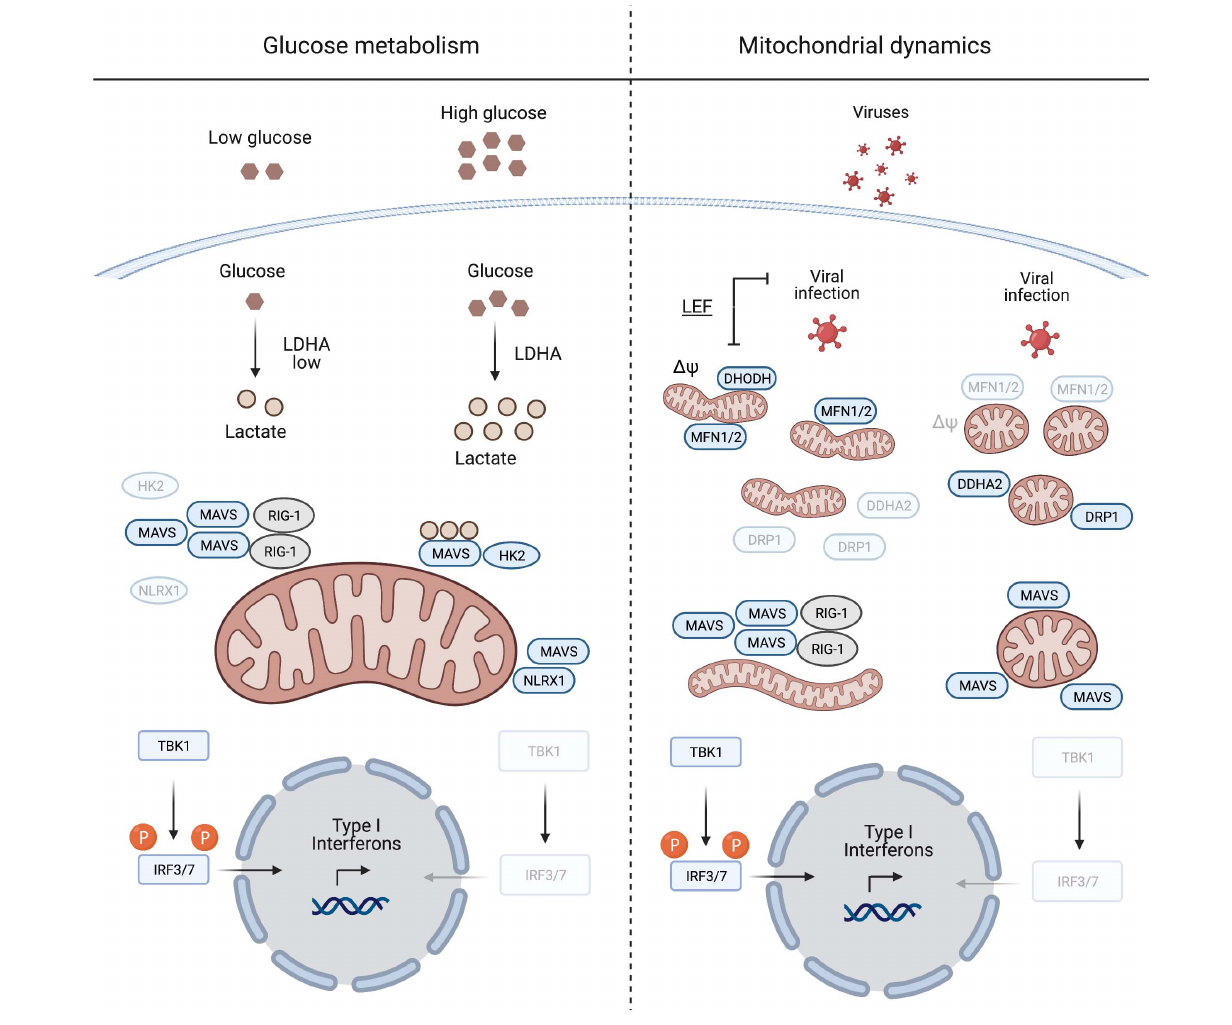
FIGURE 1 | Mitochondrial antiviral signalling protein regulation induced by glucose metabolism and mitochondrial dynamics. During viral infection MAVS aggregation is essential for mounting an IFN response to suppress viral replication. Glucose and lactate levels (together with NLRX1) are negative regulators of MAVS aggregation (left panel). The right panel illustrates the pivotal role of mitochondrial dynamics in mounting an IFN response during viral infection. Inducing mitochondrial tubulation by expressing MFN2 or preventing DRP1 mitochondrial localisation mediated by DDHA2, as well as treating cells with the DHODH inhibitor leflunomide (LEF), supports MAVS aggregation and subsequent IFN response. (cid:49) ψ , mitochondrial membrane potential. Created with